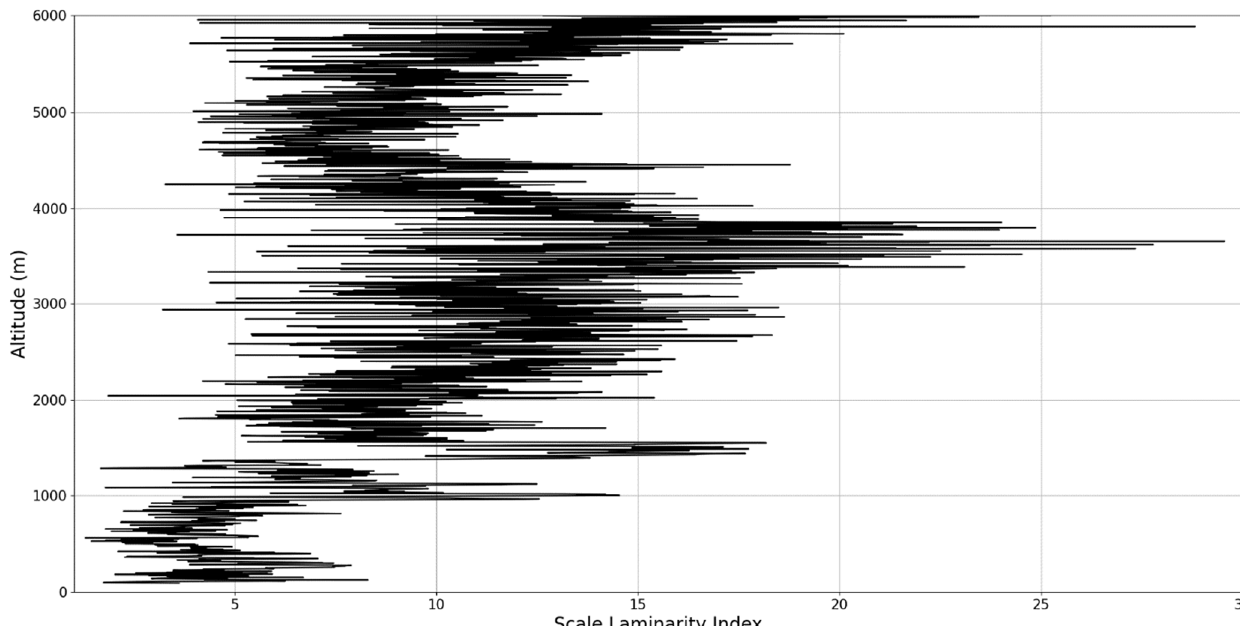
Figure 32. Scale laminarity index profile plot corresponding to point C.